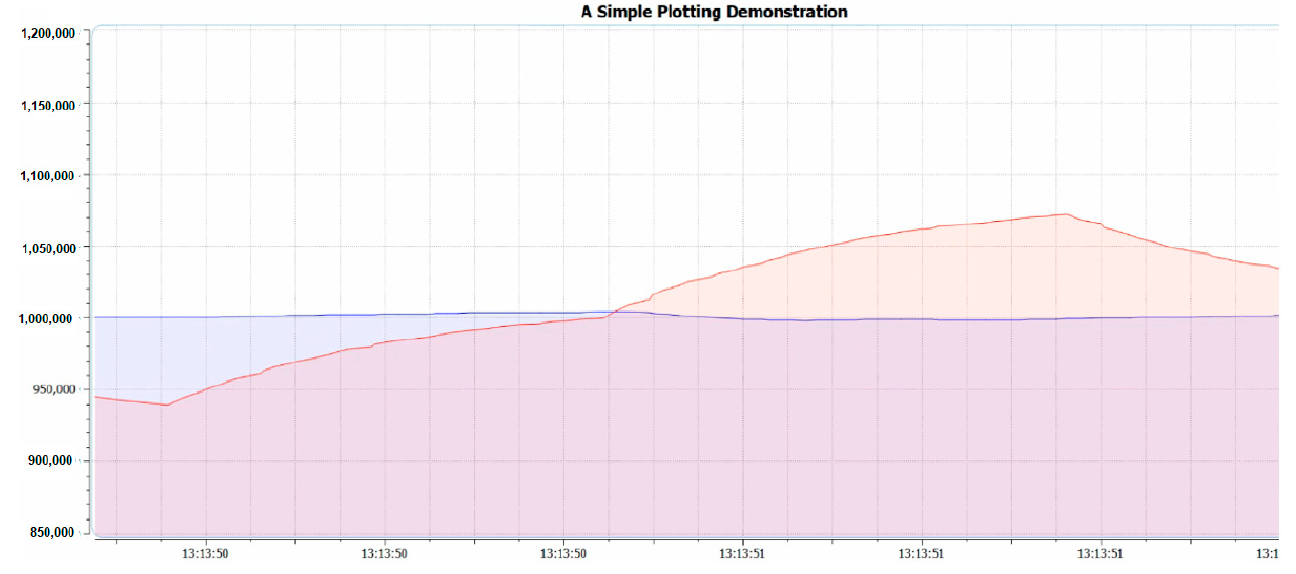
Figure 4. MAGIC_ACCEPTABLE_INTENSITY_DIFF is too small.